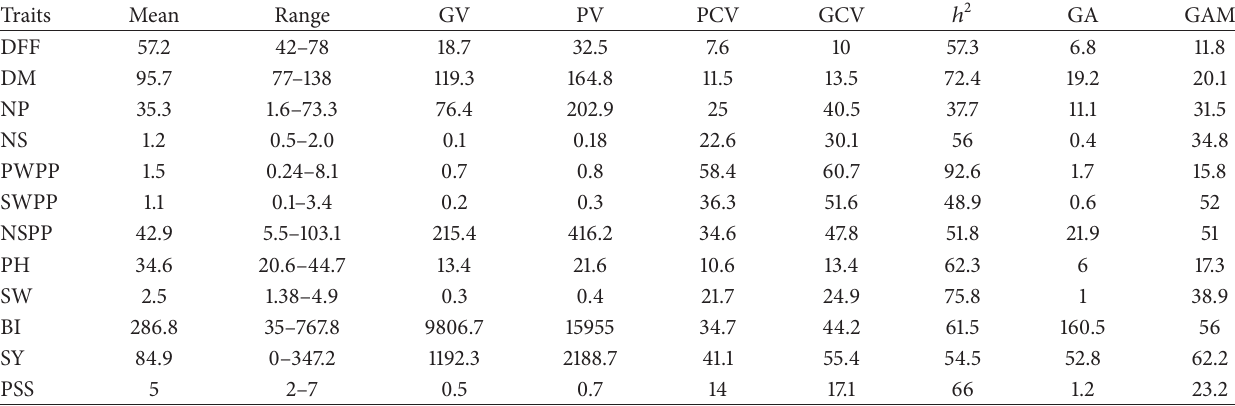
Table 8: Genetic parameter estimates for agromorphological characters of lentil genotypes at Sirinka 2010/11 cropping season. Traits